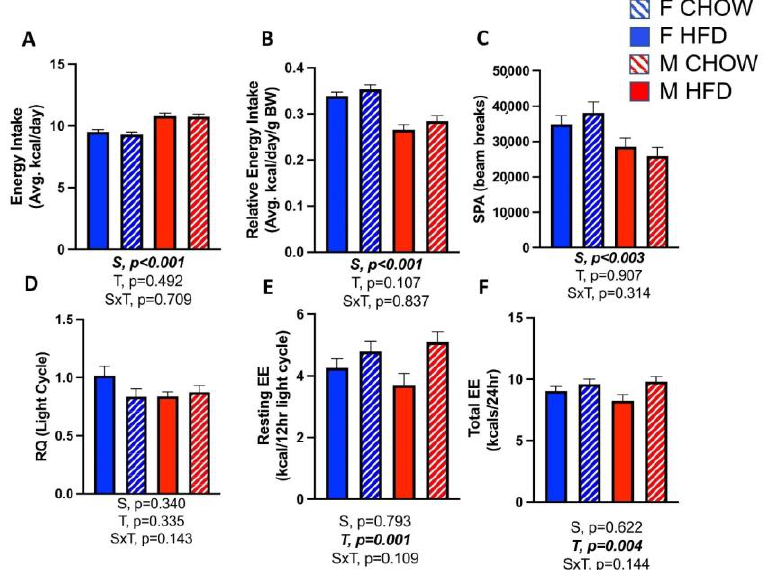
Figure 3. Male (M) and female (F) C57BL/6J mice, all on HFD, were treated for 2 weeks with daily CL injections (1 μg/g body weight) or CTRL (saline), and energy balance was assessed. ( A ) Average energy intake per day; ( B ) relative energy intake per day per g body weight; ( C ) spontaneous physical activity; ( D ) respiratory quotient (RQ) during light cycle; ( E ) resting energy expenditure (EE) (i.e., light/resting cycle EE covaried for body weight (BW)); ( F ) total EE covaried for BW. All data are presented as mean ± SEM. N = 6–10/group. Main effects of sex (S), CL treatment (T) and sex by treatment interactions (S×T) were determined by 2 × 2 ANOVA and are presented below the respective figures. p -value < 0.05 accepted as significant.